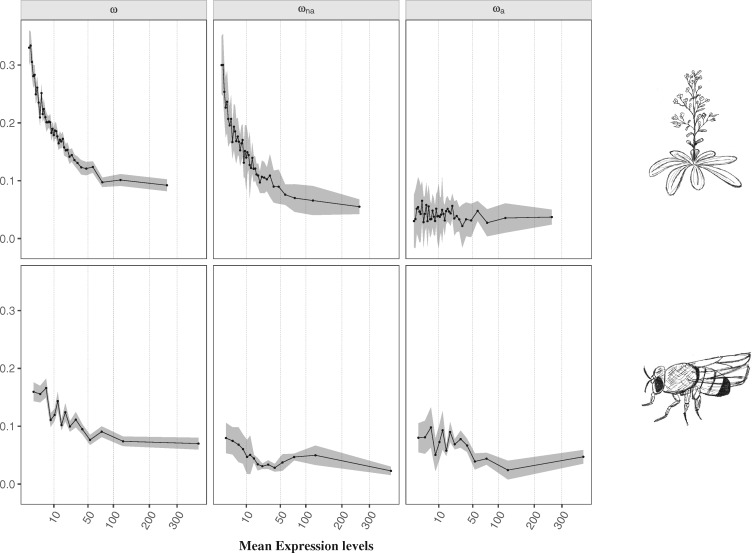
Estimates of ω, ωna, and ωa for each category of genes with distinct mean gene expression levels for Arabidopsis thaliana (top) and Drosophila melanogaster (bottom). The x axis is scaled using a squared root function. Legend as in figure 2.